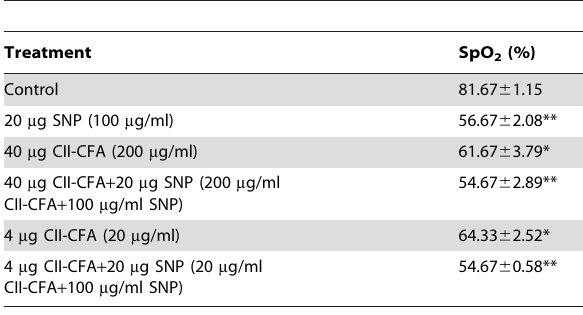
Table 4. Comparison of SpO 2 in articulates of mice after intra- articular injections by SNP, CII-CFA, or SNP + CII-CFA ( n =3).